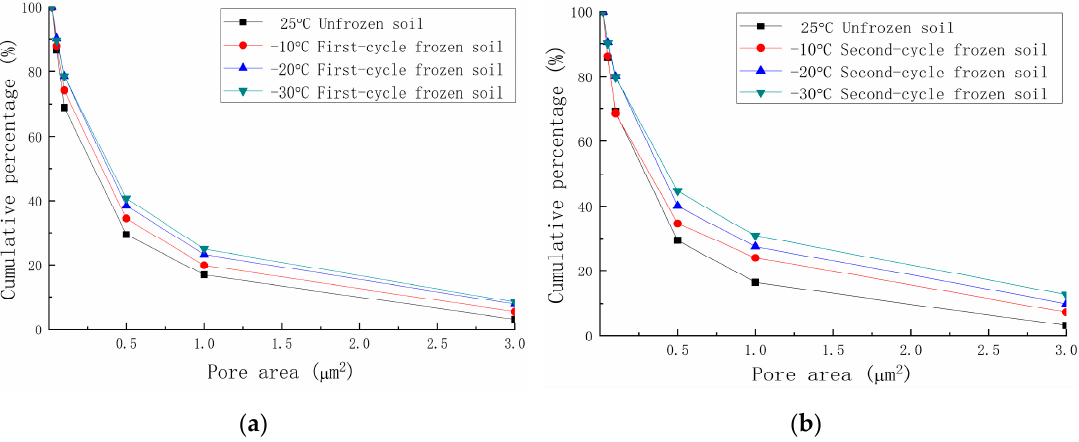
Figure 14. Pore area distribution: ( a ) first-cycle frozen soil; ( b ) second-cycle frozen soil.